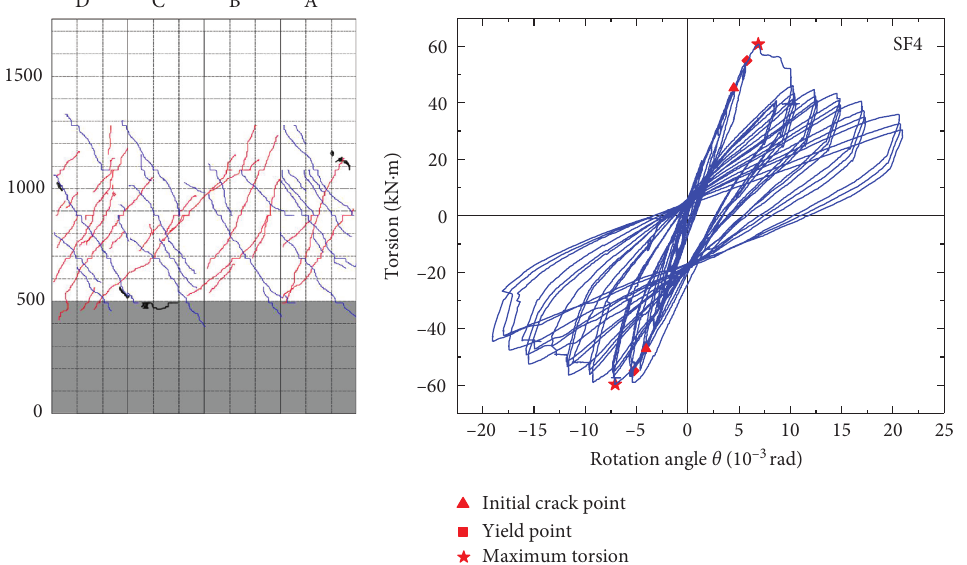
Figure 13: Damage and hysteresis curves of specimen